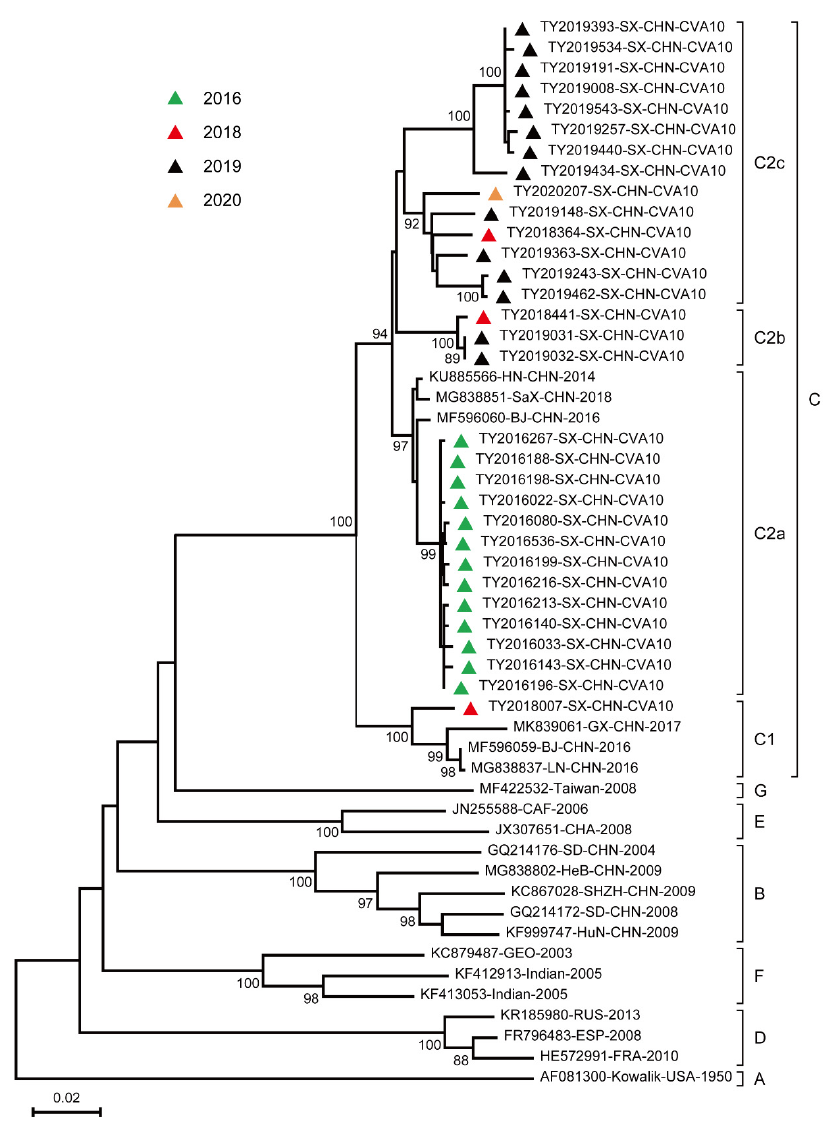
Figure 2. Phylogenetic analysis based on the complete and the available partial VP1 of CVA10. Taiyuan strains of different years were revealed by different colors according to the figure. The CVA10 nucleotide sequences in this study are represented by Serial number-Province-Country-Genotype.